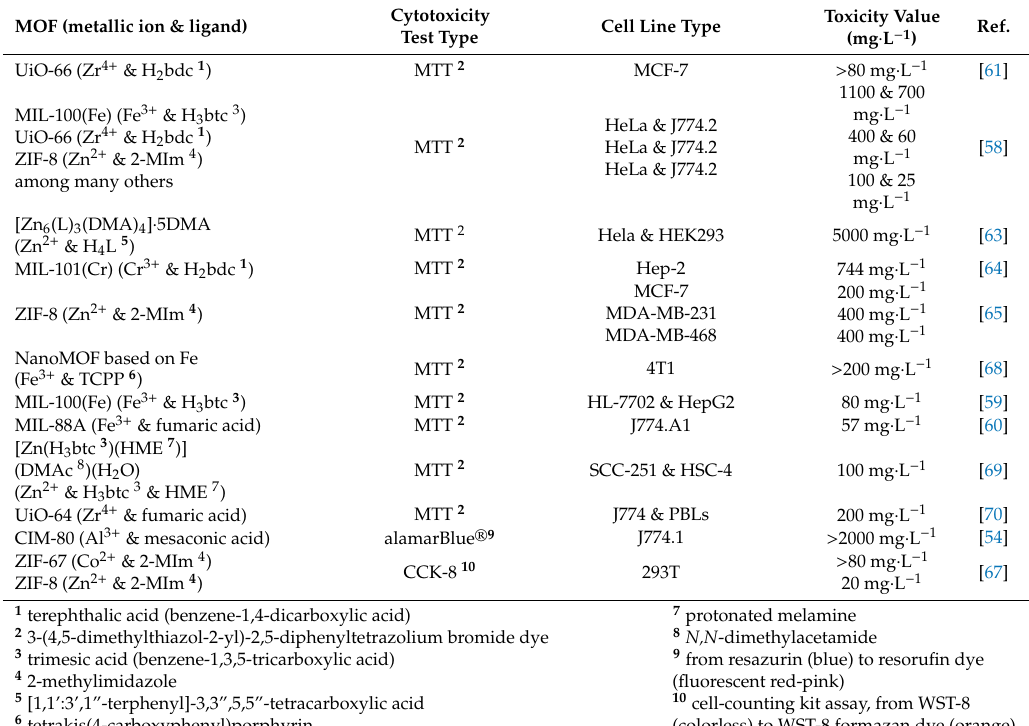
Table 1. Representative examples of cytotoxicity studies of